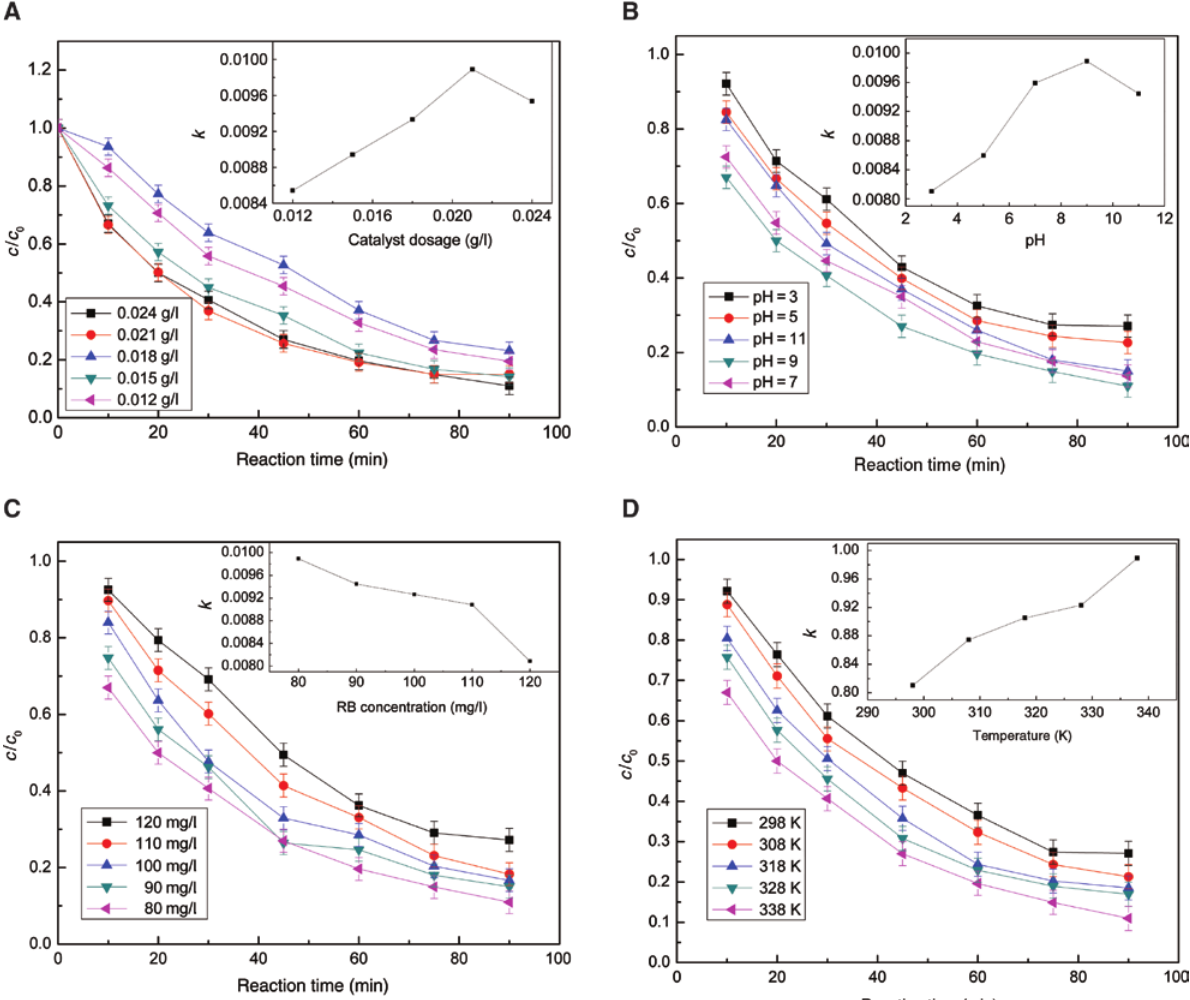
Figure 7: The effects of parameters on the degradation of RB and the fitting results of the reaction rate constant. (A) Photo-catalyst dosage, (B) pH, (C) concentration of the RB, (D)